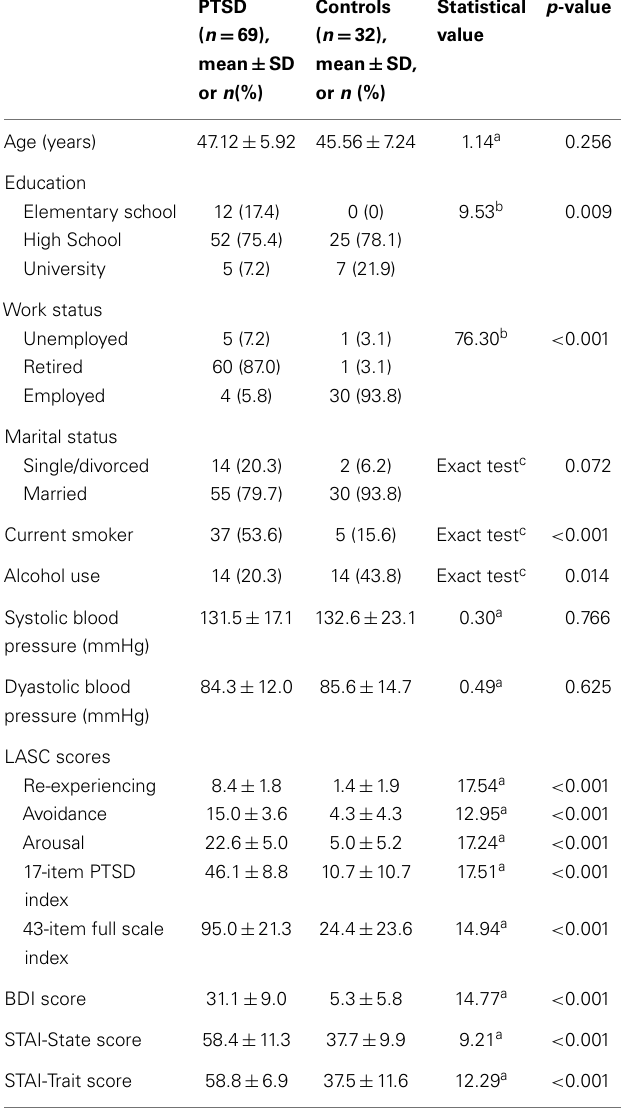
Table 1 | Participants’ characteristics and psychometric test scores (first assessment) .